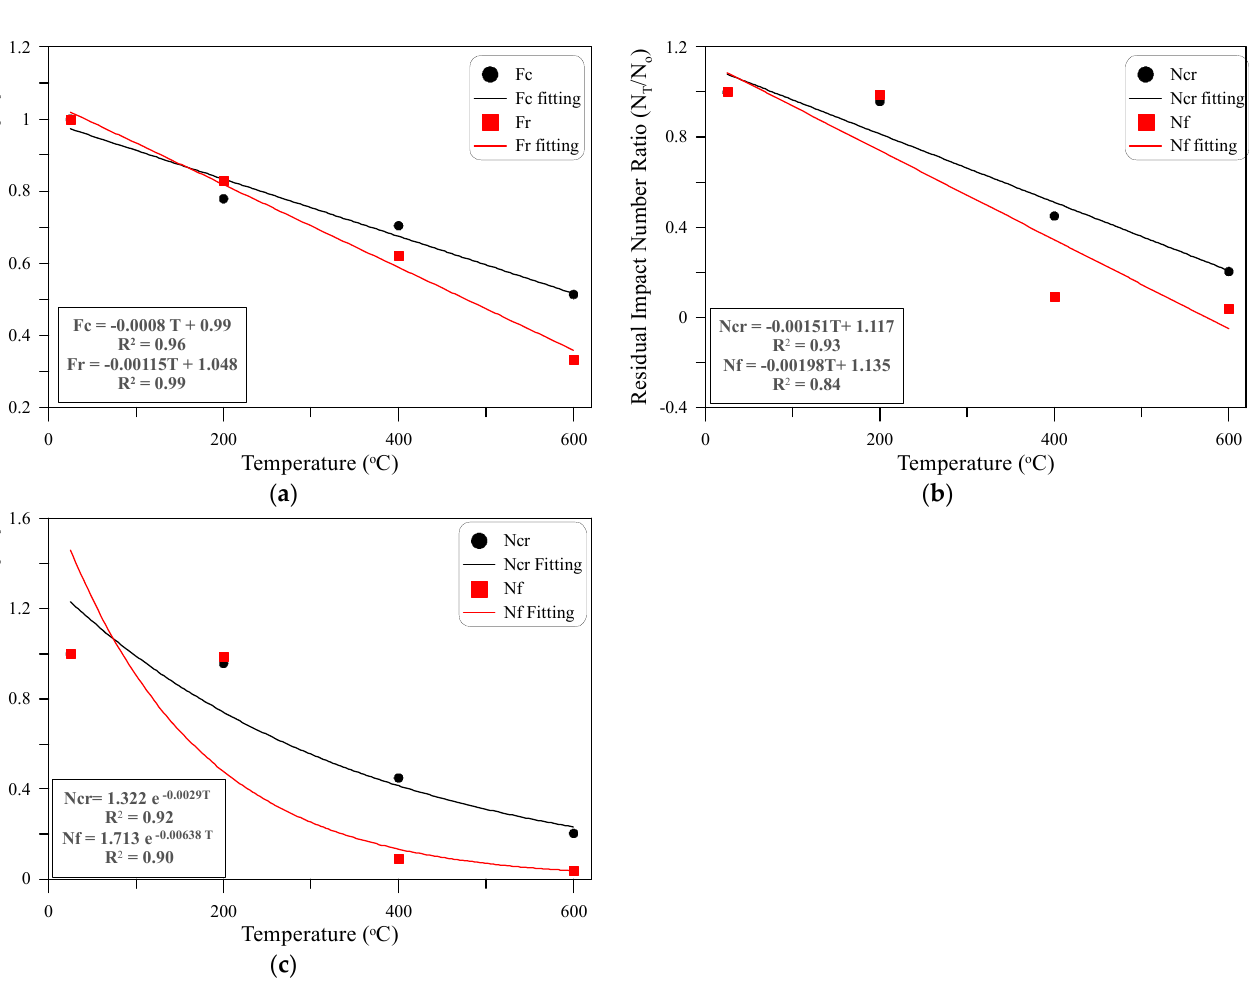
Figure 12. Correlation with temperature; ( a ) linear correlation of strength; ( b ) linear correlation of impact numbers; ( c ) exponential correlation of impact numbers.